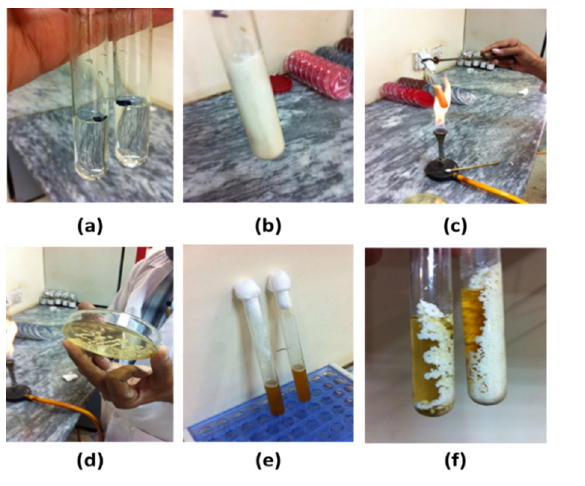
Fig. 1 (a-f): Steps in Observing the Effect of Bacillus Subtilis on Calcium Lactate